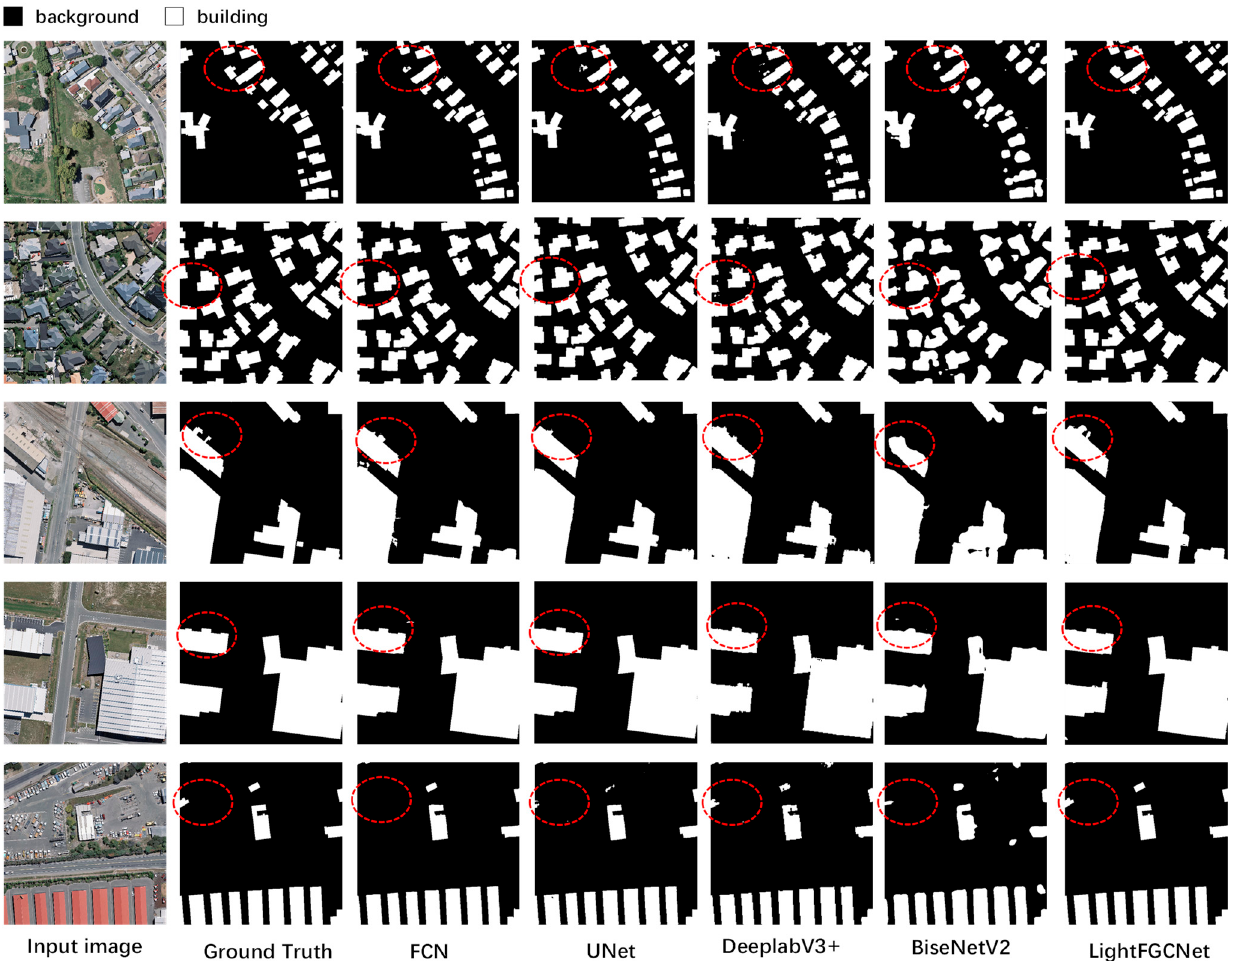
Figure 8. Prediction images of different methods on the WHU Building dataset. The red dashed lines mark the more obvious differences.